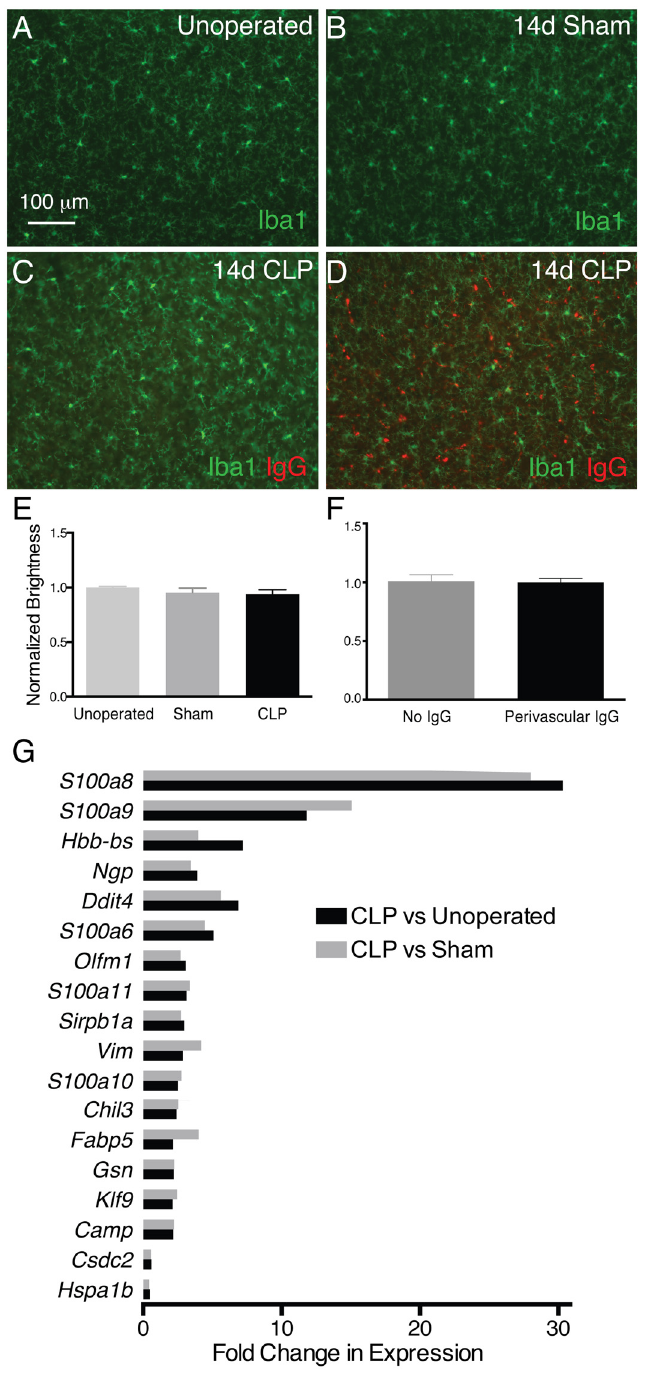
Fig 8. Microglia after CLP demonstrate distinct transcriptional differences, despite absence of morphological signs of activation. There is no difference in intensity of Iba1 immunoreactivity in somatosensory cortex among unoperated (A), sham operated (B) and post-CLP mice (C) 14 days after operation (E). There is also no difference in Iba1 immunoreactivity of microglia in regions of somatosensory cortex with evidence of vasculopathy (IgG deposition, D) compared to regions without IgG immunoreactivity (C, F). Despite the absence of activated amoeboid morphology, microglia in 14 day post-CLP mice demonstrate a distinct transcriptional profile compared to both sham operated and unoperated controls